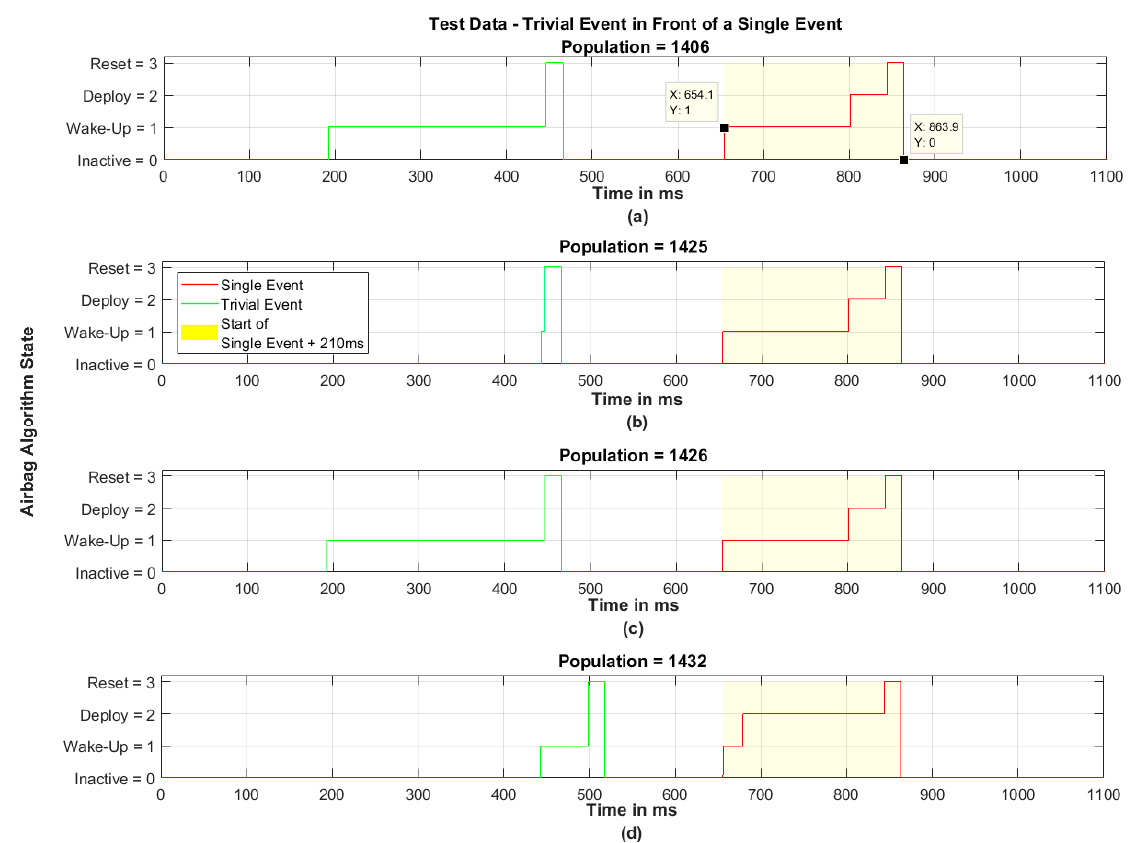
Figure 16. Case 1—Single event: four test input data at “target reached” of different populations. ( a ) Population 1406; ( b ) Population 1425; ( c ) Population 1426; ( d ) Population 1432.